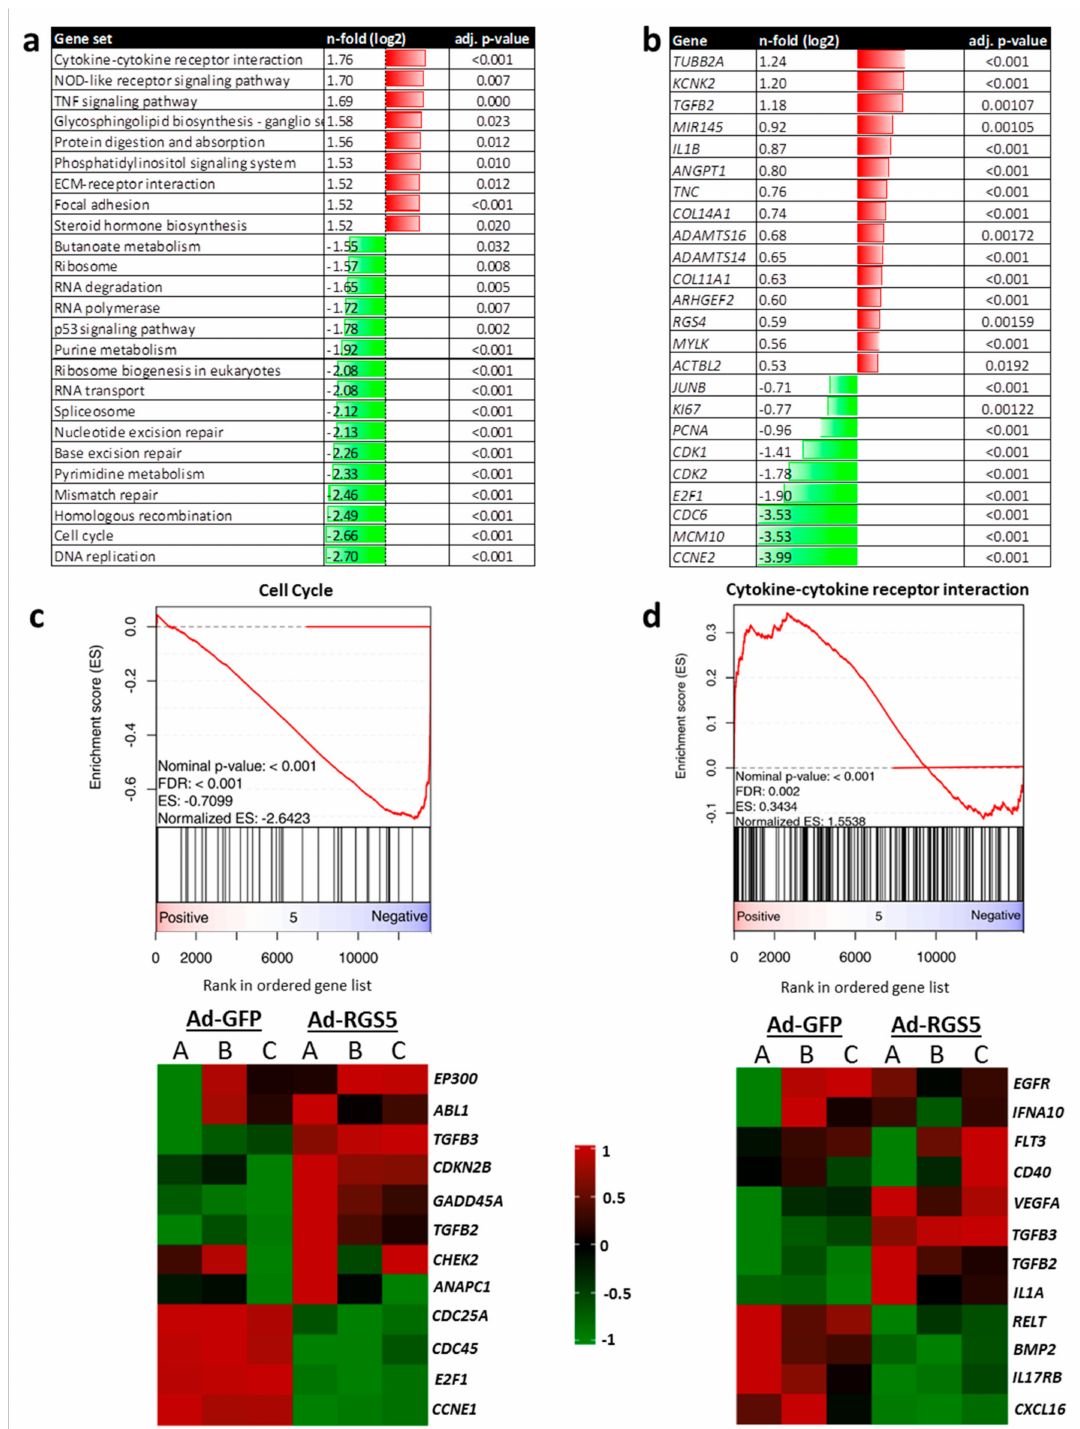
Figure 5. RGS5 overexpression in human VSMCs induces cellular quiescence. RNA from HUASMCs overexpressing GFP (Ad-GFP) or RGS5 (Ad-RGS5) was subjected to transcriptome applying a whole genome microarray (n = 3). ( a ) GSE analyses were performed by clustering genes in sets from the KEGG database pathways. The table lists gene sets which were significantly up- (shown in red) and down-regulated (shown in green) upon RGS5 overexpression with normalized enrichment score (NES) > 2.0/< − 2.0 and adjusted p -value (adj. p ) < 0.05. ( b ) List of individual top-regulated genes (red: upregulated, green: downregulated, RGS5 vs. GFP, selection criteria: log2-fold regulation >0.5/< − 0.5; adjusted p -value (adj. p ) < 0.05). ( c , d ) Representative enrichment score plots are shown for cell cycle- and cytokine-associated gene sets (NES: normalized enrichment score, adj. p : adjusted p -value). Heatmaps display the sample-specific regulation of exemplary genes attributed to these